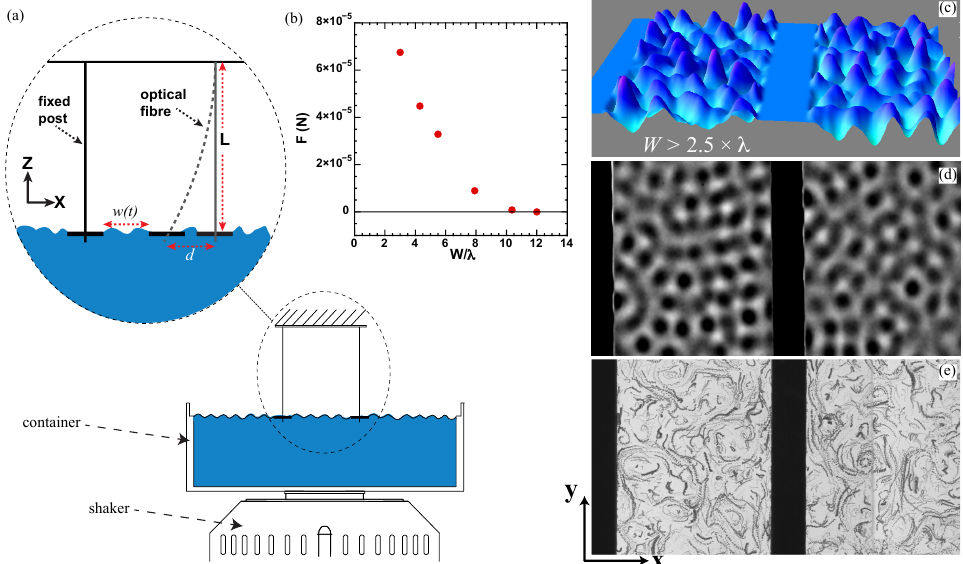
Figure 1. ( a ) Schematics of the experimental setup; ( b ) attraction force F versus non-dimensional mean separation W / λ at fixed vertical acceleration a = 1 g. Both quantities are time averaged. ( c ) 3D instantaneous visualization of the wave field topography for a beam spacing W > 2.5 × λ ; ( d ) top view of the Faraday waves using diffusive light imaging technique. Peaks and troughs appear as dark and white blobs. The floating beams appear as black rectangles (beam width = 10 mm). ( e ) the wave-driven flow, fluid particle streaks reveal the interacting eddies of the turbulent flow. Wave number spectral analysis of the flow kinetic energy reveals a k − 5/3 scaling indicating the presence of an energy